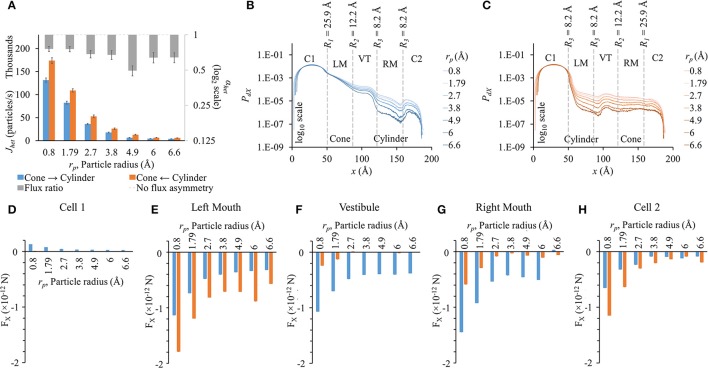
Role of particle size on flux asymmetry in heterotypic pores. Simulation results in heterotypic pore with profile 25.9-12.2-8.2-8.2 with constant concentration gradient, 2 mV transjunctional voltage and qp = 2e−. (A) Particle fluxes dropped nonlinearly as particle radius was increased from 0.8 to 6.6 Å. Flux ratio values (gray bars) ranged from ~0.5 to 0.8. Maximum asymmetry of 0.51 was for particle size of 4.9 Å. (B,C)
PdX levels remain in the same order in cell 1. PdX profiles were similar to the pore profiles (log 10 scale). (D–H) FX in the different sections of the cell-pore-cell system. (D) FX values in cell 1 were marginal compared to other sections. In general, FX magnitudes dropped in all sections of the pore with increasing particle size. (E) In the left mouth, FX dropped with increasing particle sizes with FX in cylinder to cone direction were higher than the cone to cylinder direction for all cases. FX for rp = 6 Å in the cylinder to cone direction was unexpectedly high. (F,G) In the vestibule and right mouth, FX was negative and distinctly higher in the cone to cylinder direction than in the cylinder to cone direction. (H) FX magnitudes in cell 2 were larger in the cylinder to cone direction in all cases.